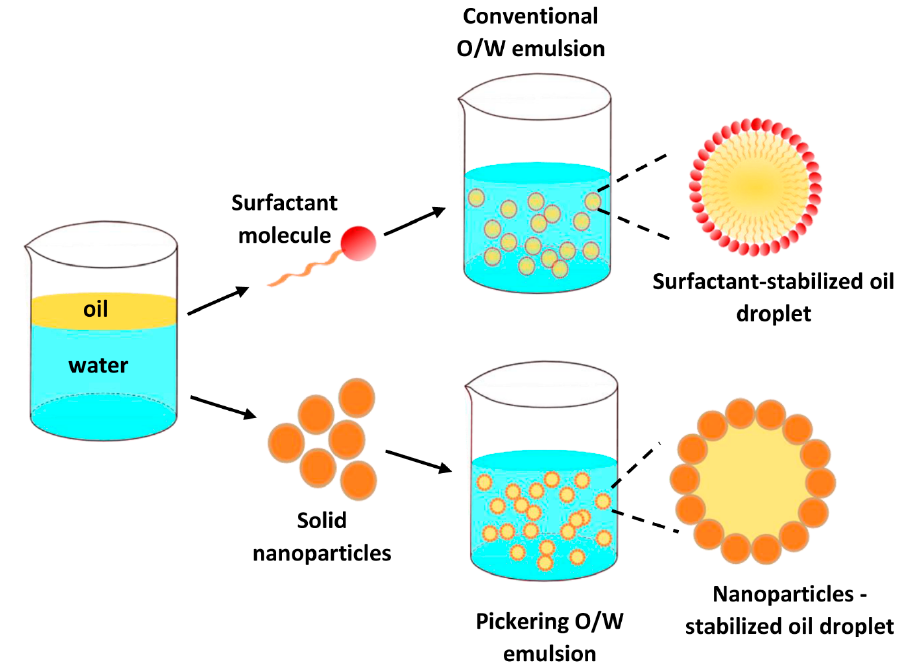
Figure 1. Schematic representation of conventional surfactant-stabilized and Pickering nanoparticle- stabilized oil-in-water (O/W) emulsions (Adapted with permission from [11]).